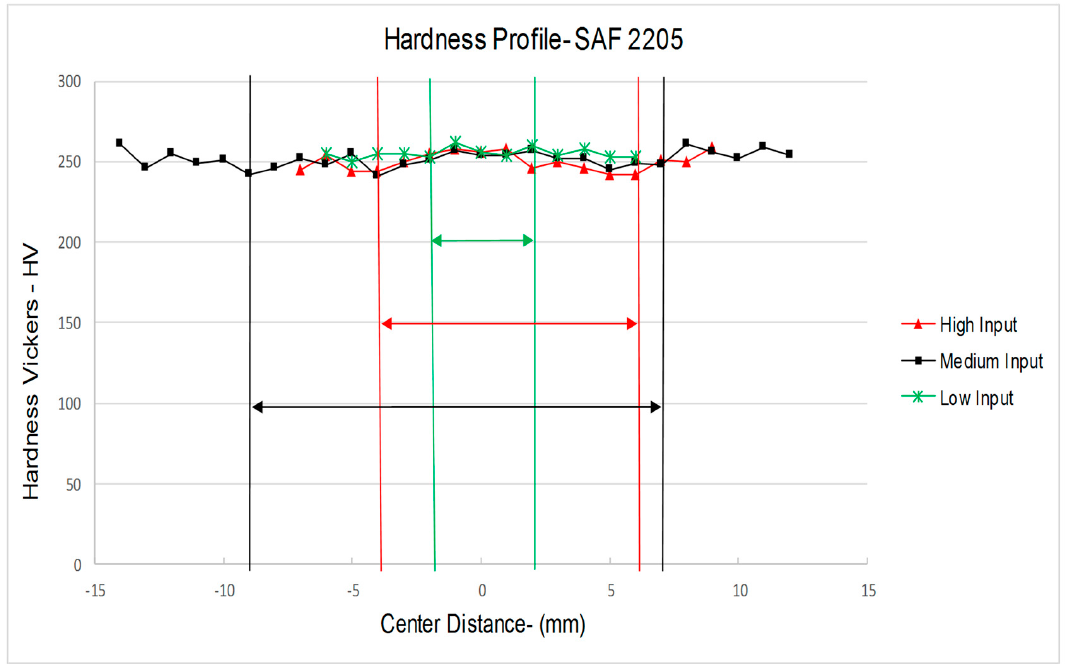
Figure 12. Vickers Hardness profile-SAF 2205. The arrows represent the distance from the weld center. i.e., width of WM. Values were measured from the base metal to the base metal, i.e., BM, LT-HAZ, HT-HAZ, WM, HT-HAZ, LT-HAZ, BM.